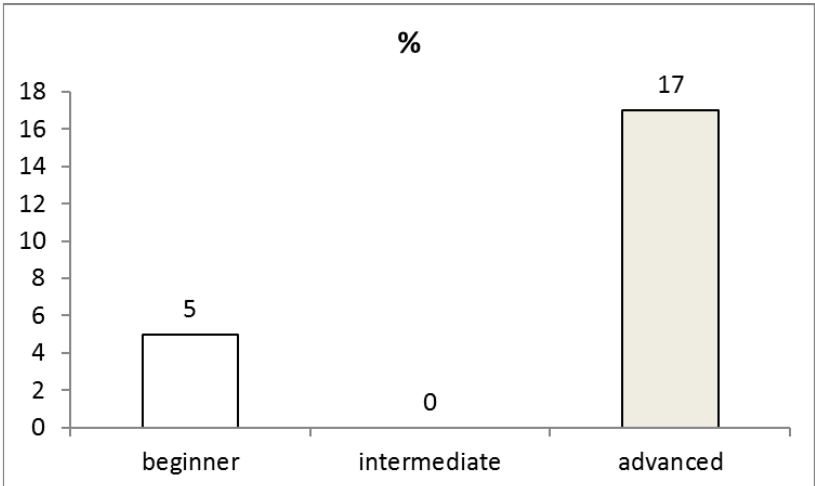
Figure 2. The injury rate depending on the level of technical skills